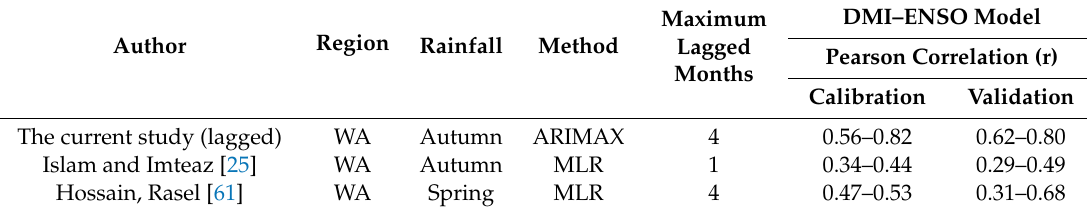
Table 9. Pearson correlation (r) between combined climate indices and Western Australian rainfall.